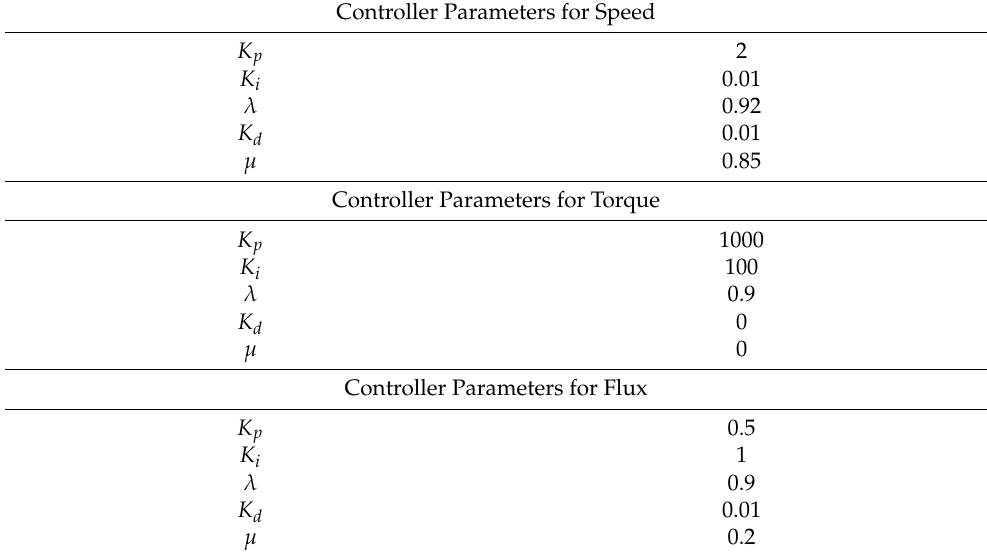
Table 3. Controller